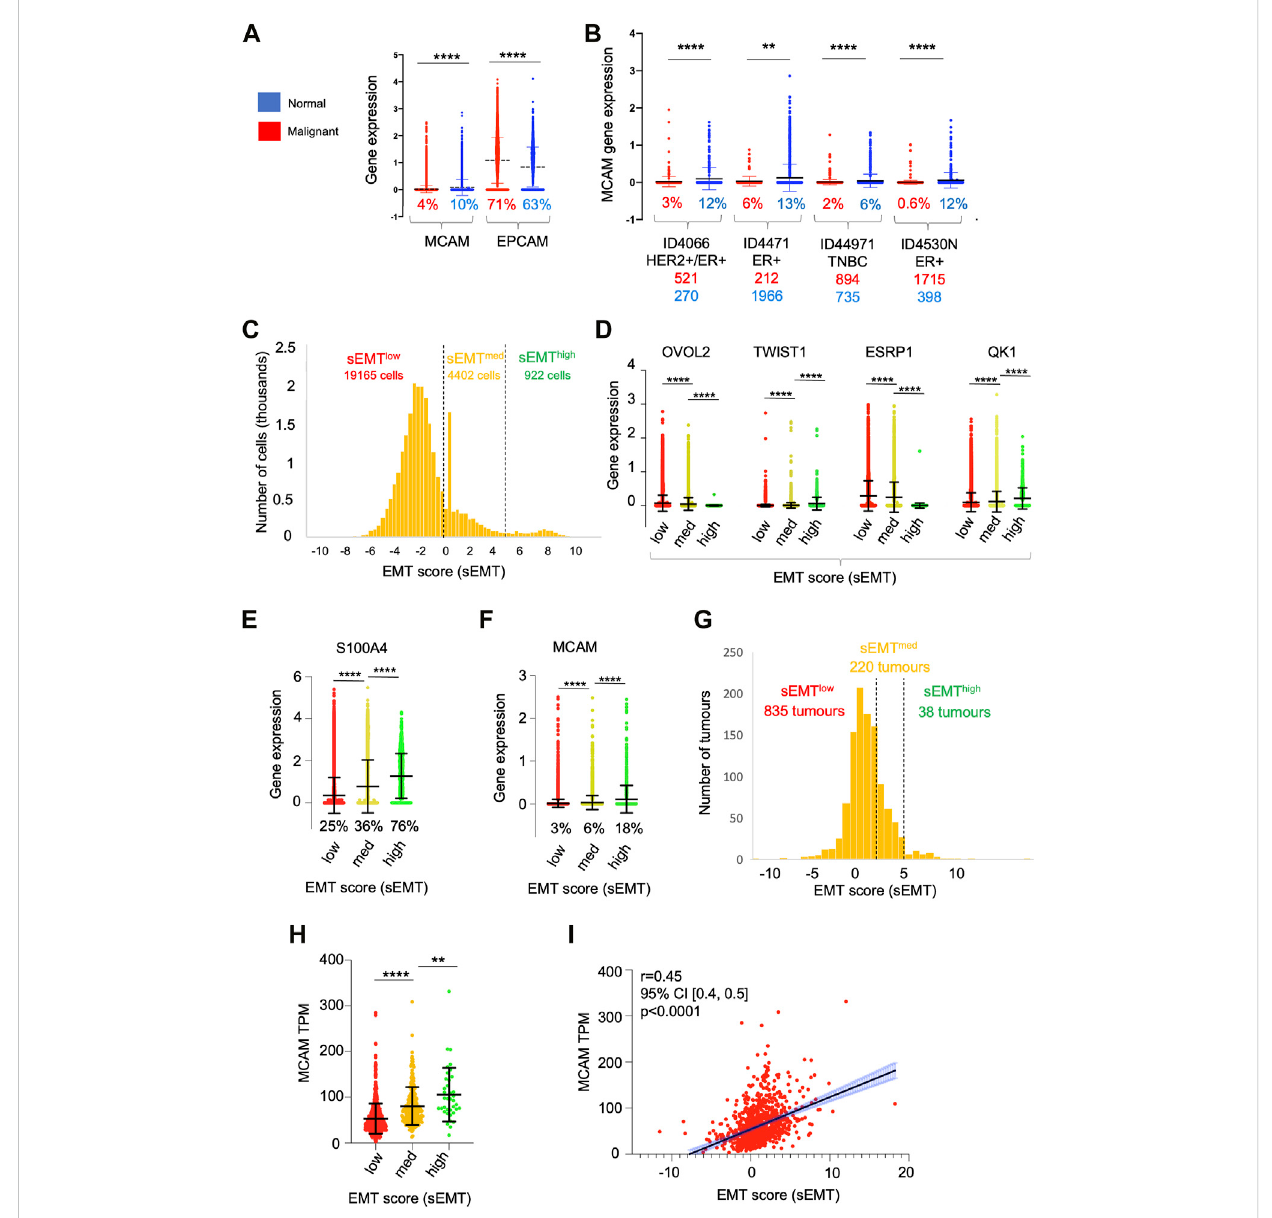
FIGURE 7 Heterogeneity of gene expression in malignant cells. (A) MCAM and EPCAM gene expression in single malignant cells (red; n = 24,489) and single normal epithelial cells (blue; n = 4,355), as identi fi ed by Wu et al. (2021). Percentages indicate the proportion of expressing cells (expression > 0). Differencesinexpressionwereanalysed usingatwo-tailedMannWhitney test;**** p < 0.0001. (B) MCAM geneexpressionas in (A) ,exceptperformedon four individual patients from the study. Anonymised patient IDs and the phenotype of their tumour (Wu et al., 2021) are shown along with the percentage of MCAM expressing cells in the malignant (red) and normal epithelium (blue). The number of malignant and normal epithelial cells in each tumour is also shown in red and blue respectively. Differences in expression were analysed using a two-tailed Mann Whitney test; ** p < 0.01, **** p < 0.0001. (C) Population distribution of 22,489 malignant cells with respect to their EMT score (sEMT). The positions of the sEMT low , sEMT med and sEMT high sub-populations are indicated, along with the number of cells in each sub-population. (D) Expression of EMT regulators in the sEMT low , sEMT med and sEMT high sub-populations. Gene expression of the transcription factors OVOL2 and TWIST1 and the RNA splicing factors ESRP1 and QK1 are indicated. Data was analysed using a two-tailed Mann Whitney test; **** p < 0.0001. (E) Expression of the S100A4 gene in the sEMT low , sEMT med and sEMT high populations. Data was analysed using a two tailed Mann Whitney test; **** p < 0.0001. (F) Expression of the MCAM gene in the sEMT low , sEMT med and sEMT high populations.Data wasanalysed usingatwo-tailed MannWhitney test; **** p < 0.0001. (G) Populationdistributionof1,093tumours(from TCGA) with respect to their EMT score (sEMT × 10 − 3 ) The positions of the sEMT low , sEMT med and sEMT high tumours are indicated, along with the numbers of tumours in each group. The sEMT groups were de fi ned as follows; sEMT low =sEMT < 2,000, sEMT med =sEMT < 5,000, sEMT high =sEMT > 5,000. (H) Expression of the MCAM gene in the 1,093 breast cancer tumours from TCGA de fi ned as sEMT low , sEMT med or sEMT high tumours. Differences in expression were analysed using a two-tailed Mann Whitney test; ** p < 0.01, **** p < 0.0001. (I) Correlation of MCAM gene expression and sEMT for the in the 1,093 breast cancer tumours from TCGA. Spearman ’ s r, con fi dence intervals (and associated p -value) are